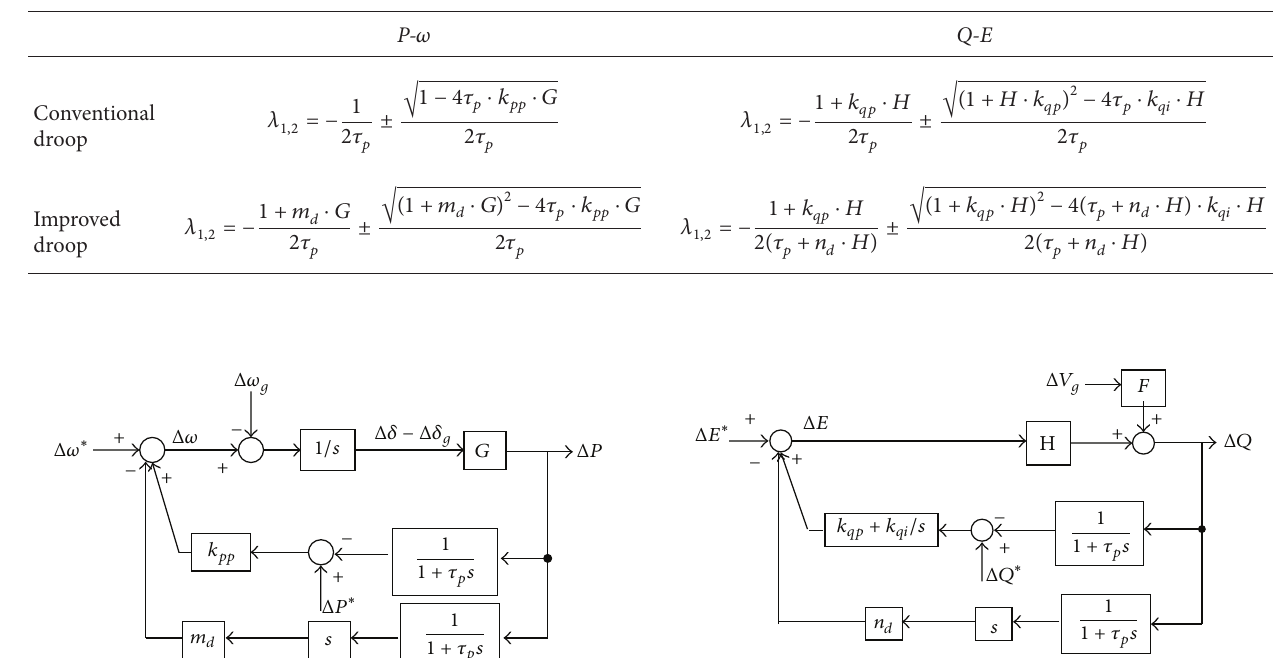
Table 1: Brief comparison of eigenvalues.